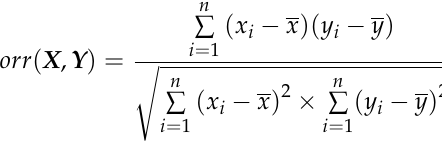
Figure 8. Comparison of the experimental and numerical (from the models of current study and other numerical studies) water profiles at different times: ( a ) t = 0.5 s; ( b ) t = 1.0 s.